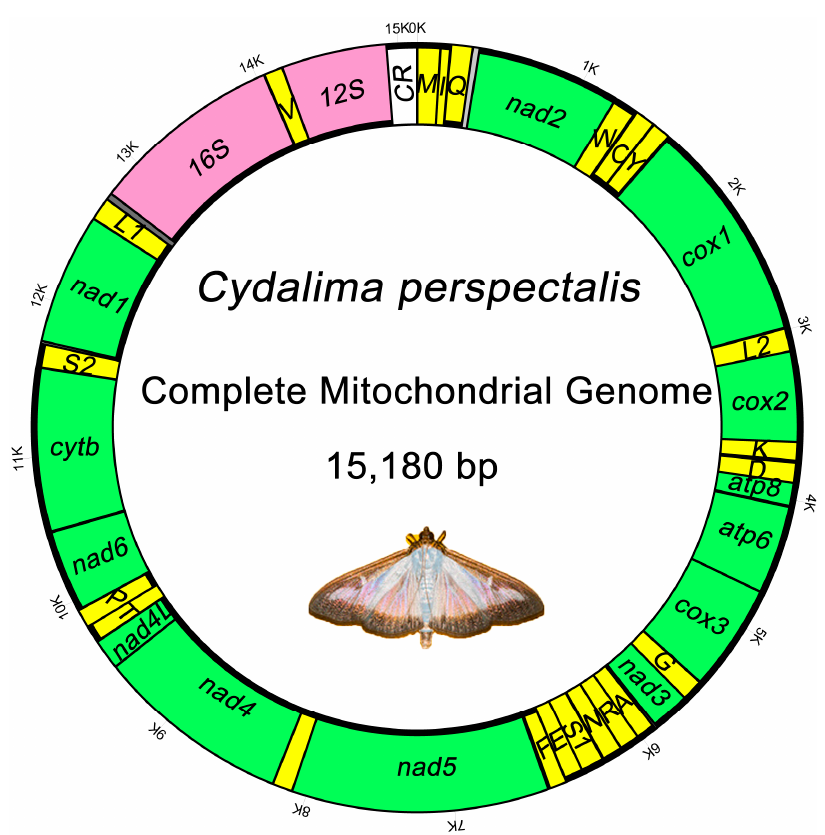
Figure 1. Circular map of the mitochondrial genome of C. perspectalis . The nucleotide composition of the C. perspetives mitogenome is as follows (Table 3): A = 6058 (39.9%), T = 6231 (41.0%), G = 1162 (7.7%), and C = 1729 (11.4%). The A + T of the C. perspectalis mitogenome’s nucleotide composition was 81.0%. The entire GC-skew and AT-skew of the C. perspectalis mitogenome were − 0.014 and − 0.196, respectively. The AT skew for the C. perspectalis mitogenome was slightly negative. This suggests that T nucleotides are more abundant than A nucleotides. The GC-skew for the C. perspectalis mitogenome was scarcely negative, with C nucleotides outnumbering G nucleotides. In addition, AT-skew (0.014) and GC-skew (0.185) of the tRNAs indicate that tRNAs